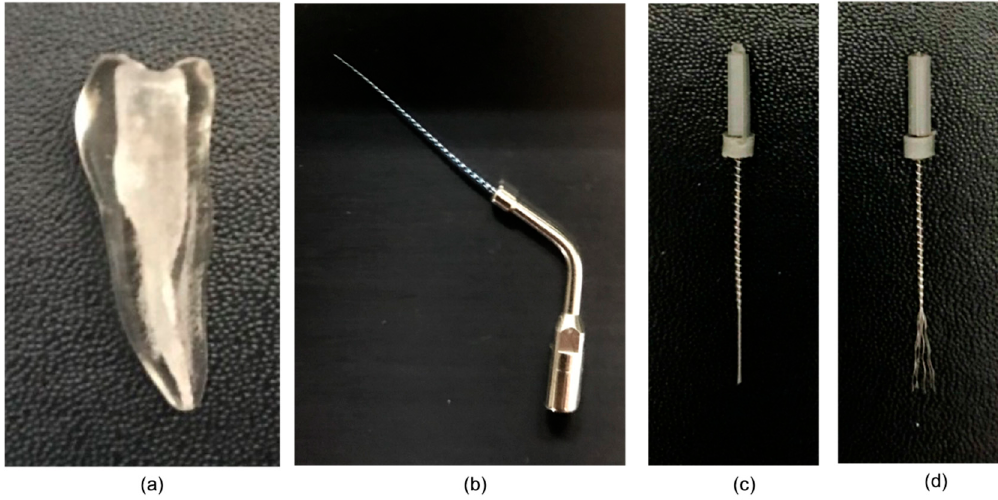
Figure 1. ( a ) Artificial plastic tooth sample; ( b ) Endosonic Blue tip; ( c ) strand twisted Gentlefile Brush; ( d ) strand unfolded Gentlefile Brush.